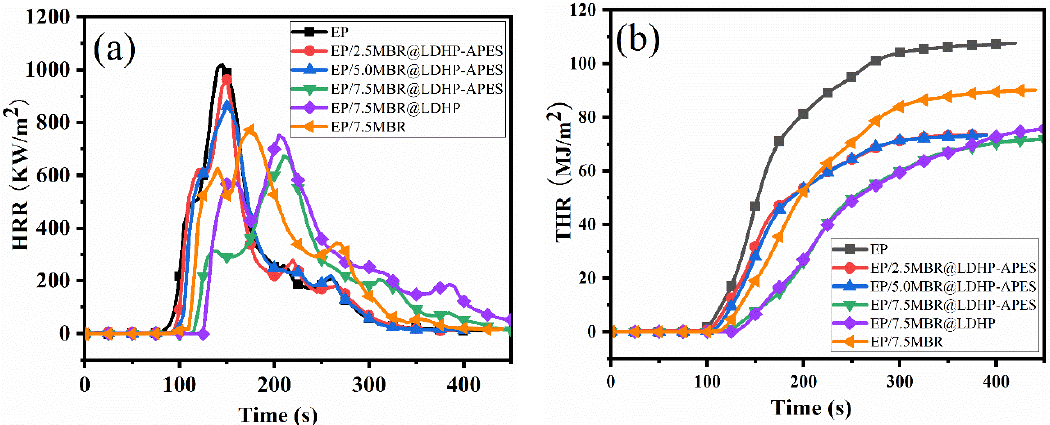
Figure 7. HRR ( a ) and THR( b ) curves of pure EP and its composites. 312 Table 4. CCT test results for EP and its composites.